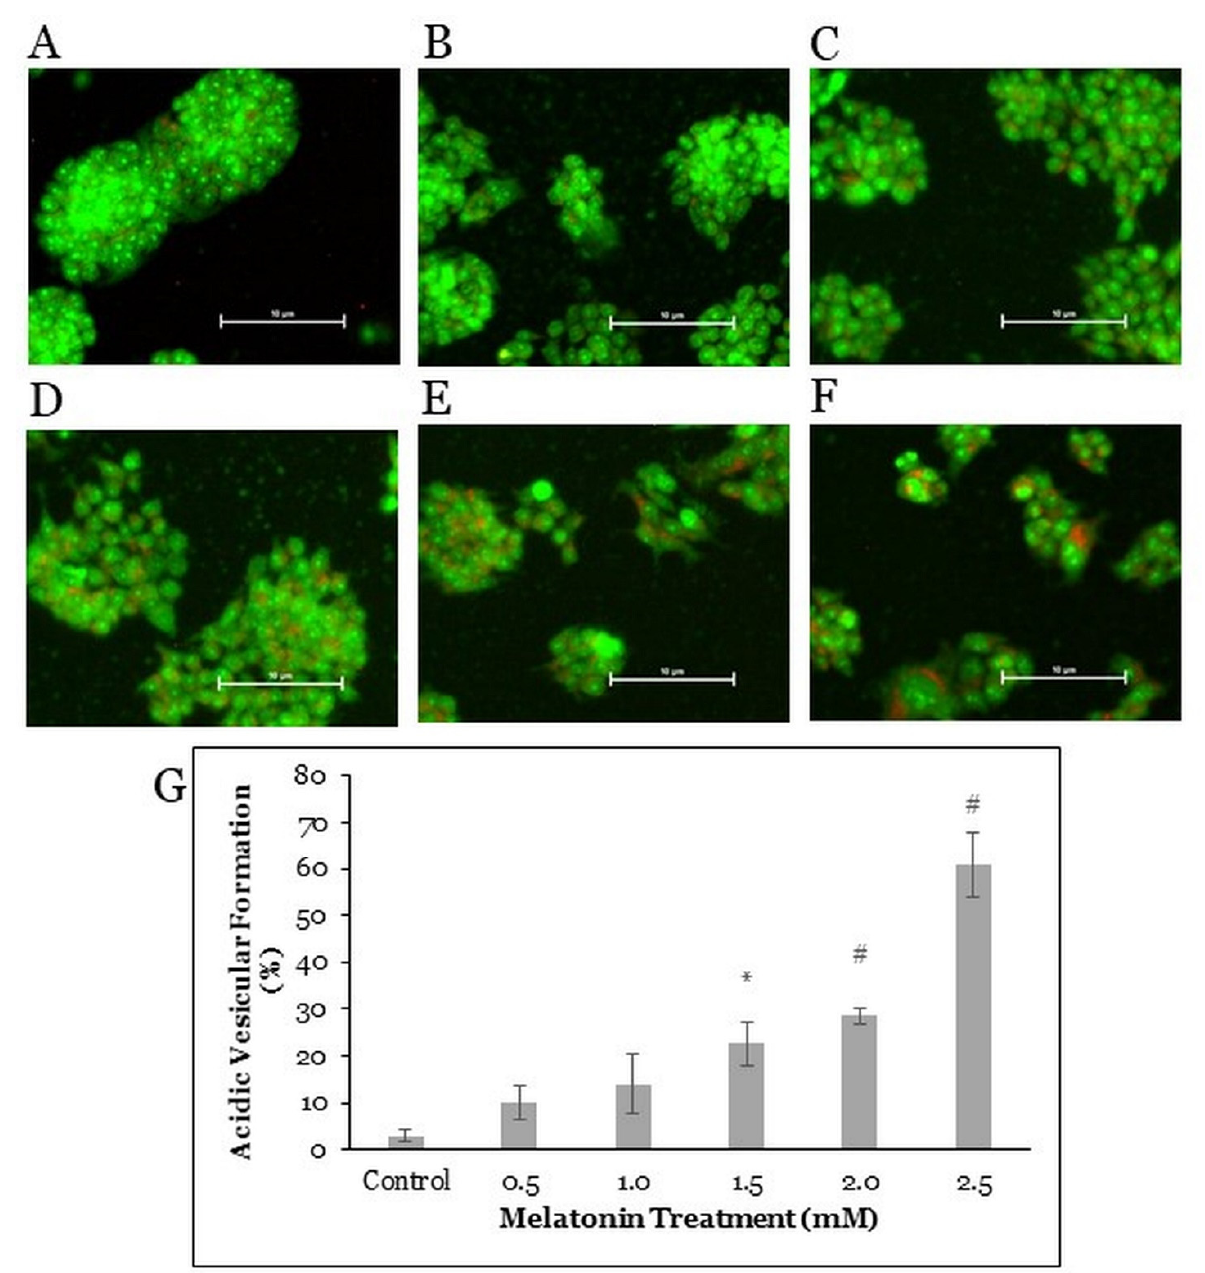
Figure 3. Acridine orange fluorescent staining in HT-29 cells. The HT-29 cells were treated with various concentrations of melatonin for 72 h: ( A ) control, ( B ) 0.5 mM, ( C ) 1.0 mM, ( D ) 1.5 mM, ( E ) 2.0 mM, and ( F ) 2.5 mM. Cells were stained with 5 μ g/mL of the acridine orange dye for 20 min, then visualized under a fluorescence microscope with 200× magnification. ( G ) The bar graph represents the means ± SEM of three separate experiments. One-way ANOVA, followed by Dunnett’s post hoc test, was performed to compare each treatment group with the control. Statistically significantly different from control: *, p < 0.05; #, p < 0.01.